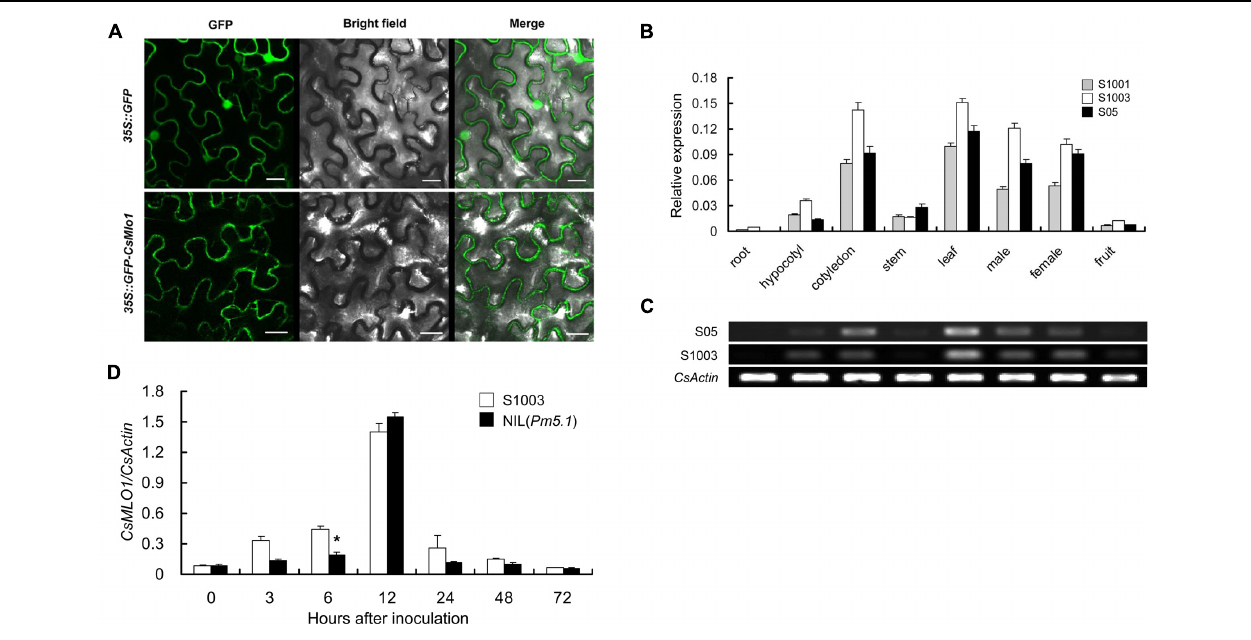
FIGURE 3 | Subcellular localization and expression pattern of CsMLO1 . (A) 35S::GFP and 35S::GFP-CsMLO1 constructs were transiently expressed in tobacco leaf epidermal cells. The fusion protein GFP-CsMLO1 was localized in the cell membrane. Scale bars = 20 µ m. (B,C) Spatial expression patterns of CsMLO1 alleles in roots, hypocotyls, cotyledons, stems, leaves, male flowers, female flowers, and fruits of S1001, S1003, and S05 according to qRT-PCR (B) and semi-quantitative RT-PCR analyses (C) . S05 and S1003 indicate the CsMLO1 allele expression in cucumber lines S05 and S1003, respectively. (D) Time-dependent expression pattern of CsMLO1 in resistant S1003 and susceptible NIL( Pm5.1 ) plants after PM inoculation. The cucumber CsActin gene was used to quantify the relative transcript levels of CsMLO1 . Values are mean ± SE ( n = 3) ( ∗ indicates significant difference between S1003 and NIL( Pm5.1 ) at the P = 0.05